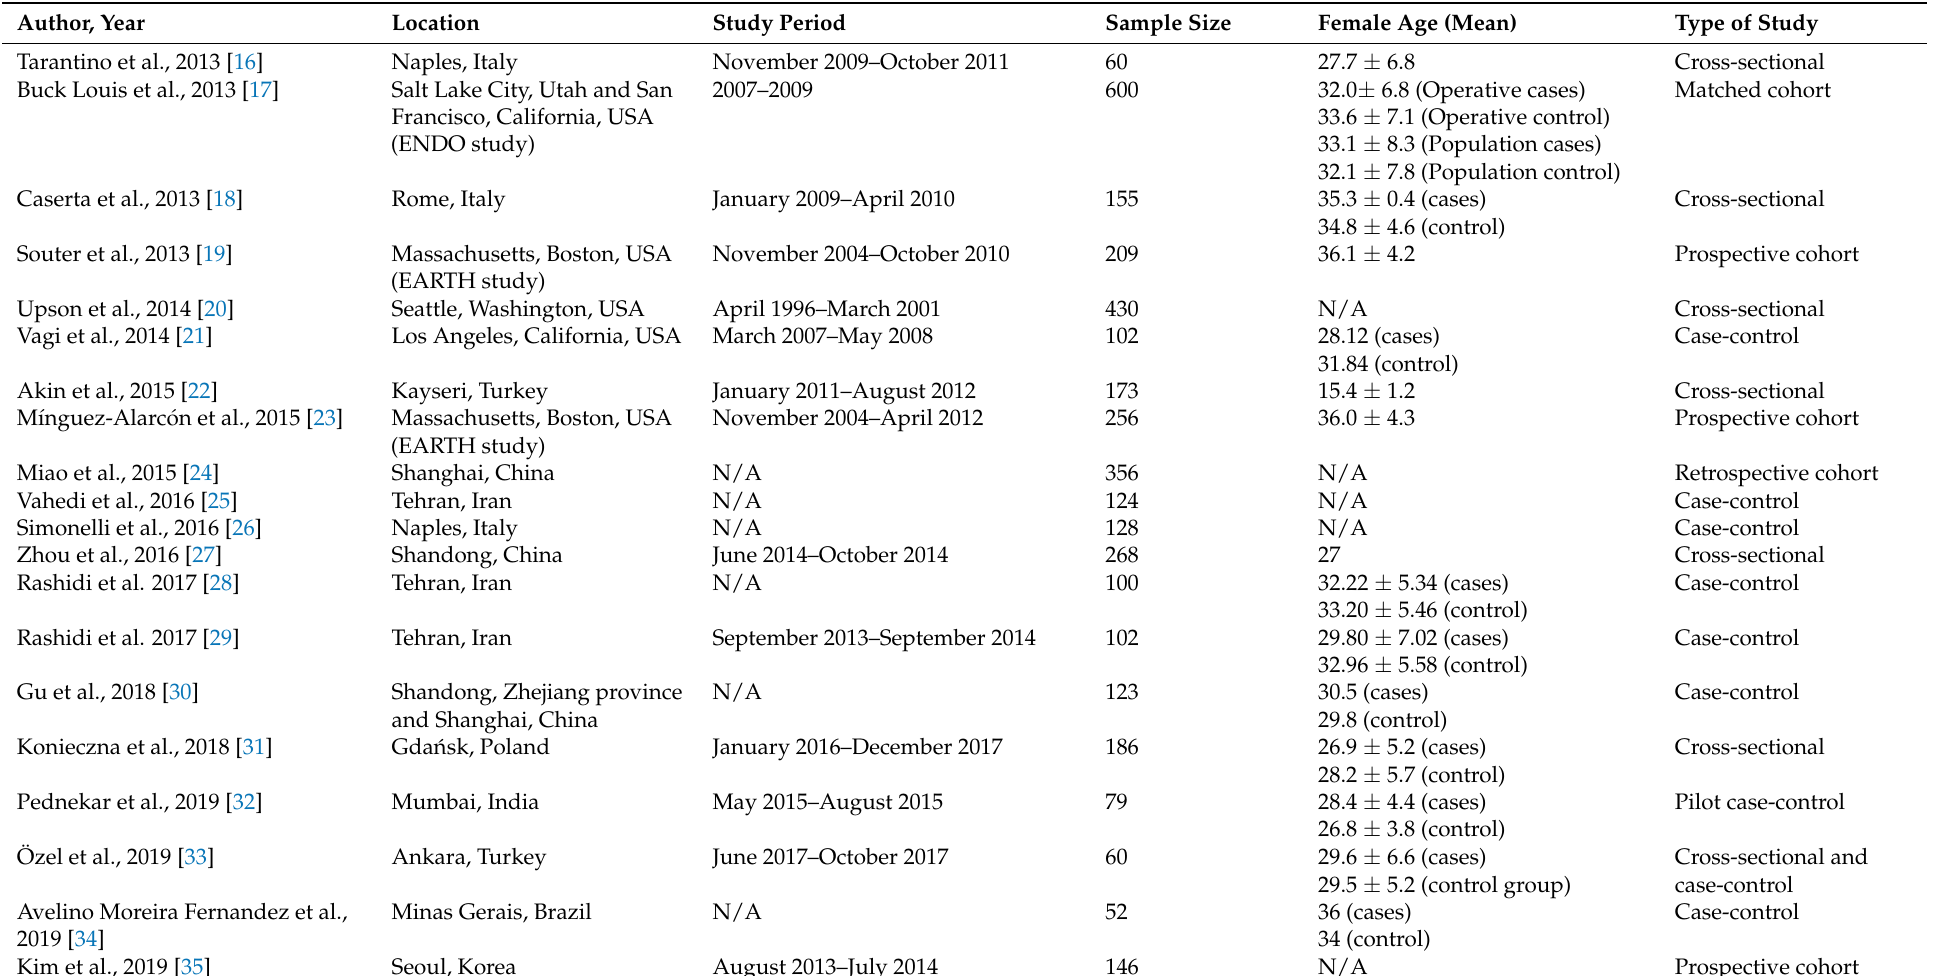
Table 1. Characteristics of studies